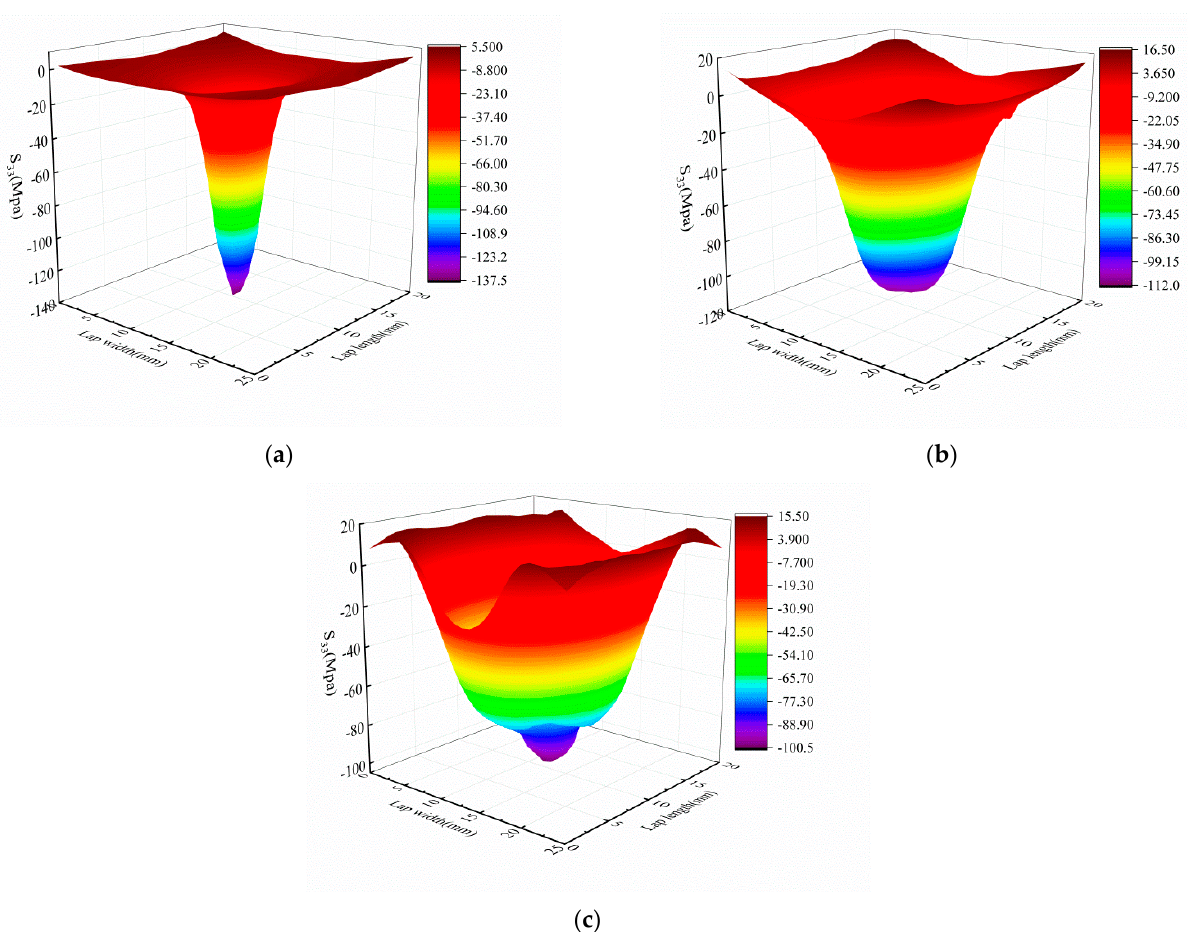
Figure 16. The normal stress distribution of the adhesive layer at different loading points of SLJs under 30 J impact. ( a ) 0.2 F ; ( b ) 0.6 F ; and ( c ) F.